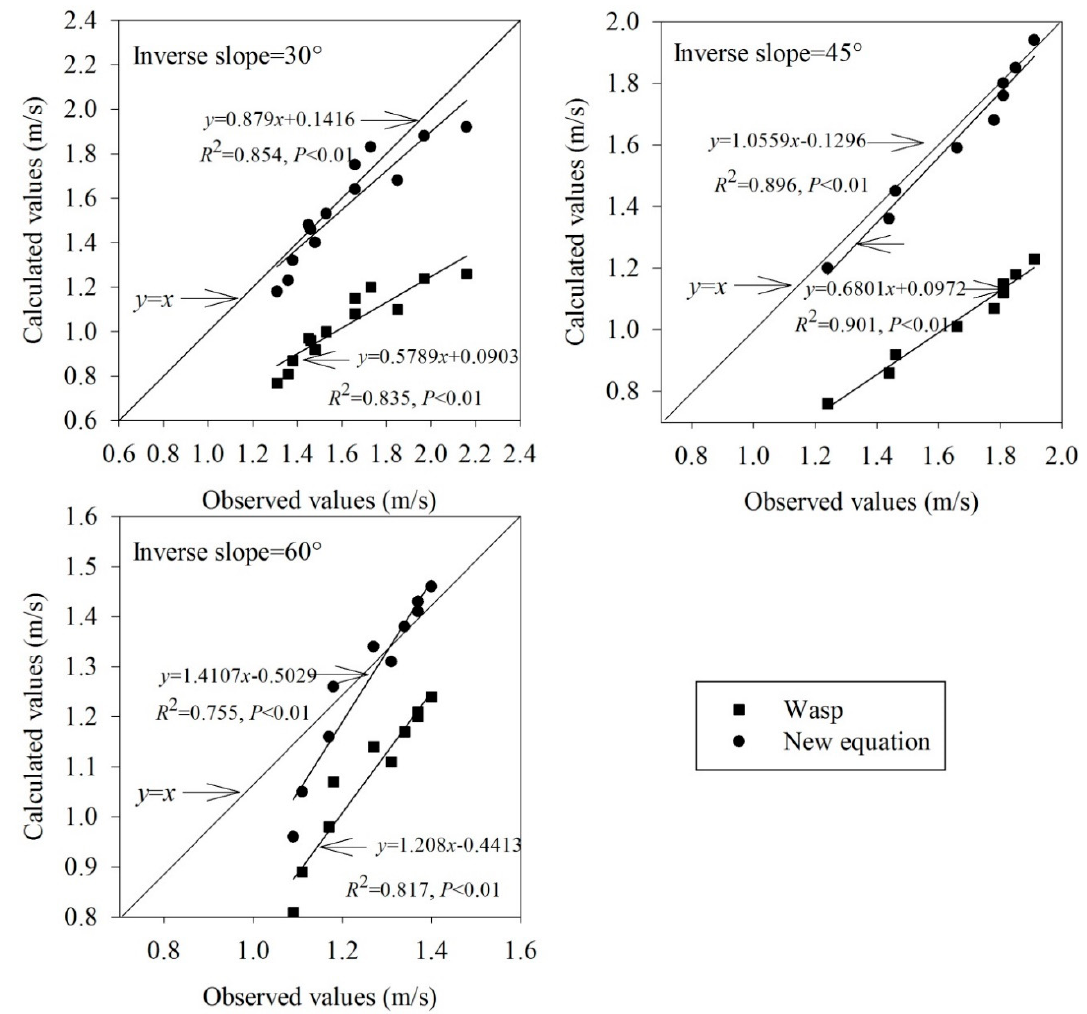
Figure 6. The measured critical deposition velocity compared with the new equation and the Wasp equation. Table 4. A comparison of the observed and simulated values of the critical deposition velocities. Slope Observed (m /